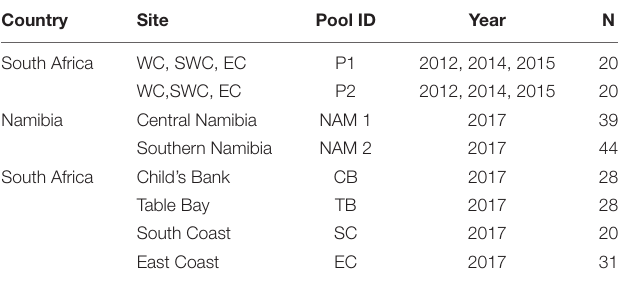
TABLE 1 | Sampling location (Country and Site), code (Pool ID), year and number of individuals sampled per pool (N). Country